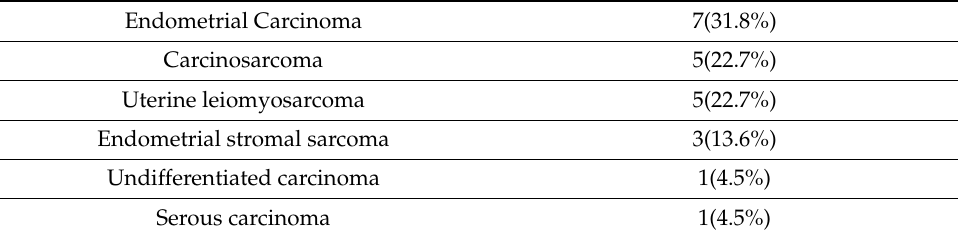
Table 5. Histopathological findings.